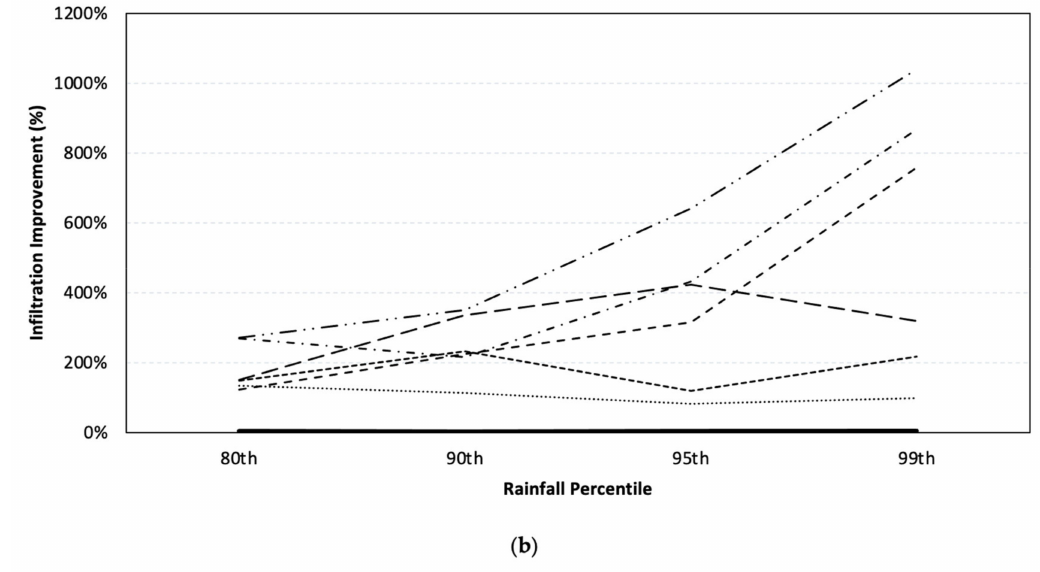
Figure 9. The improvement of infiltration using optimal scenarios under the ( a ) optimistic and ( b ) pessimistic cost